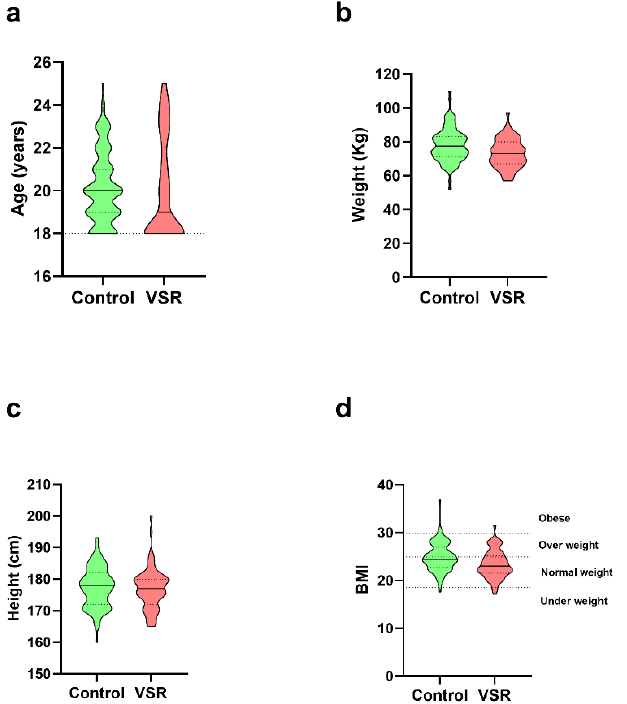
Figure 3. Anthropometric data: ( a ) age; ( b) weight; ( c ) height and ( d ) BMI of control group (green) and VSR (red) individuals. BMI: Body Mass Index.